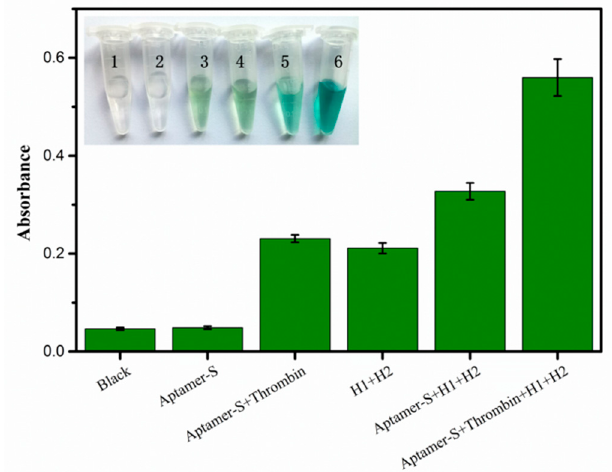
Figure 6. Absorption intensity value of TMB of different samples. Inset: the corresponding photographs of the colorimetric responses. The concentrations of thrombin, Aptamer-S, H1, and H2 are 1 nM, 50 nM, 300 nM, and 300 nM, respectively. Error bars show the standard deviation of three experiments.